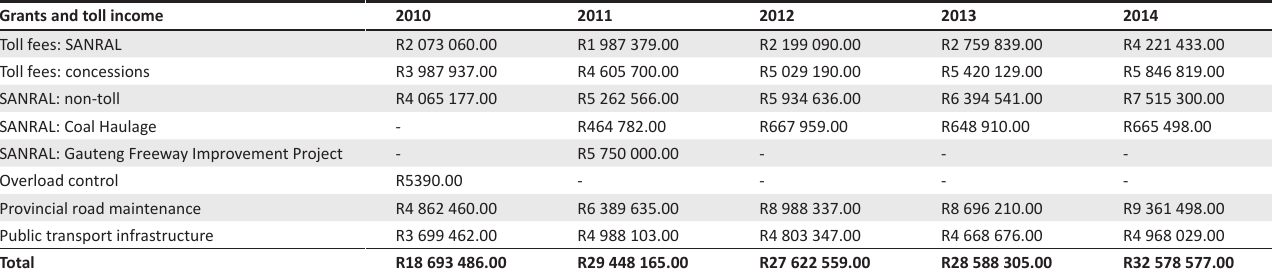
TABLE 2: Allocated income